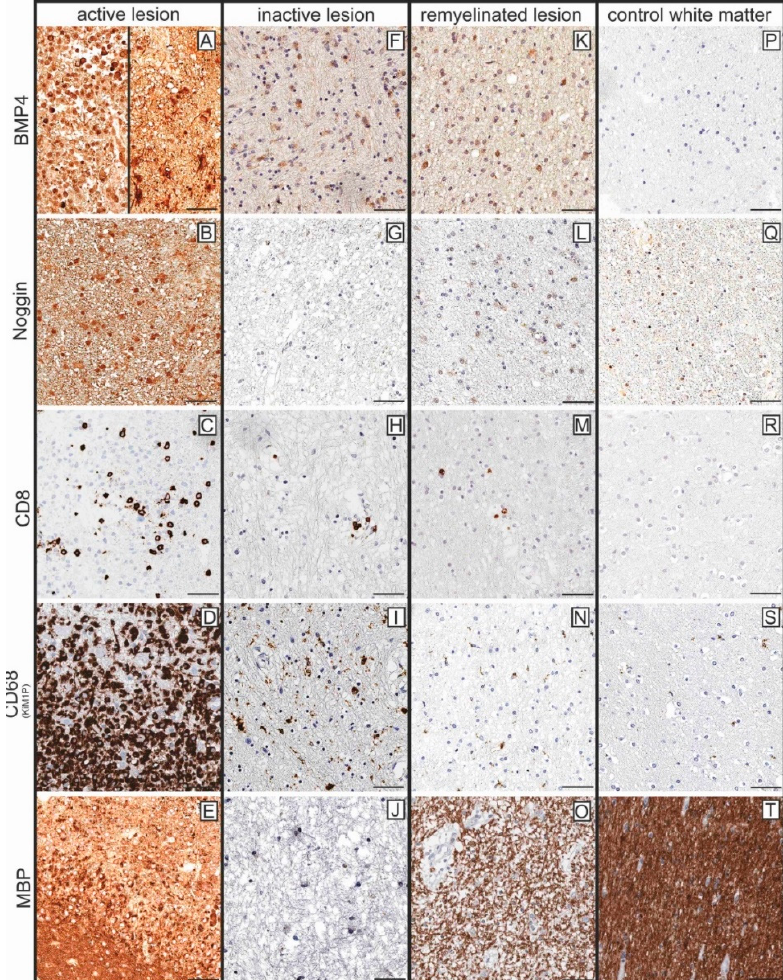
Figure 2. Comprehensive immunohistochemical investigation of the white matter pathology of BMP4 and its antagonist Noggin (representative results). ( A – E ) inflammatory (early active*) lesion: BMP4 ( A ) is strongly expressed in foamy macrophages (left) in the lesion. In the lesion rim (right), astrocytic cells with clear overexpression of BMP4 are frequently seen. Increased expression of the BMP4 antagonist Noggin in active lesions ( B ). The inflammatory infiltrate was shown here with the T cell marker CD8 ( C ), which detects more than 50% of the T-cells in the infiltrate (Supplementary Figure S1). The foamy macrophages in the lesion are marked positively in the staining against CD68 (KiM1P) ( D ). In the marginal area of the lesion, the staining against the myelin protein MBP ( E ) shows intact myelin sheaths (lower area). In addition, some macrophages are present in the infiltrate (middle region) in whose cytoplasm myelin degradation products are recognizable (in this case MBP; CNP also contained in macrophages, not shown). ( F – J ) chronic inactive lesion: BMP4 ( F ) is expressed in some astrocytes in the lesion center. Noggin is hardly expressed ( G ). In the chronically inactive lesions, only a few T-cells (CD8, H ) and slightly activated microglia/residual macrophages (CD68 (KiM1P), ( I ) are still present. Myelin sheath are not detectable any more in the lesion centre (MBP, J ). ( K – O ) remyelinated lesion area: BMP4 ( K ), like Noggin ( L ), is expressed in some cell elements in remyelinated lesion areas. Also in these lesion areas there are only few inflammatory infiltrates (CD8, M ) and only solitary activated microglial cells (CD68 (KiM1P), N ). In the MBP staining some thin (newly formed) myelin sheaths are stained ( O ). ( P – T ) white matter control tissue: No cells are marked positively in staining against BMP4 ( P ). Some cells express Noggin ( Q ). No T-lymphocytes are marked in the parenchyma ( R ). Only solitary microglial cells are detected in staining against CD68 (KiM1P) ( S ). The myelin sheaths are intact (MBP, T ). (* early active in this context means that, in addition to inflammatory infiltrate in macrophages, small phagocytosed myelin protein fragments (CNP, not shown) could be detected in the lesion [17]); (scale bar = 50µm).